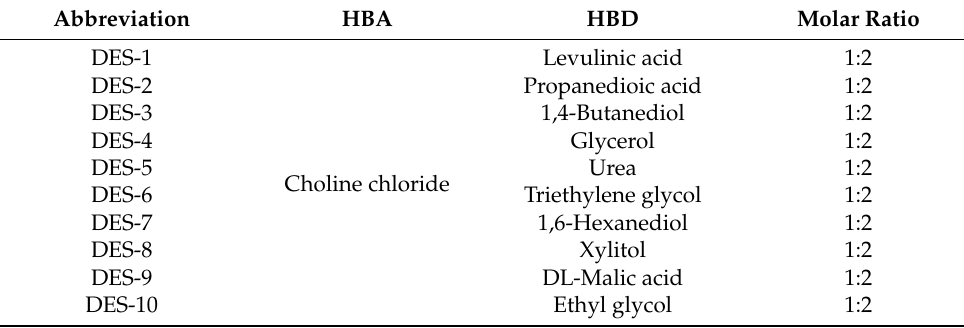
Table 1. List of DESs synthesized and tested for macamide